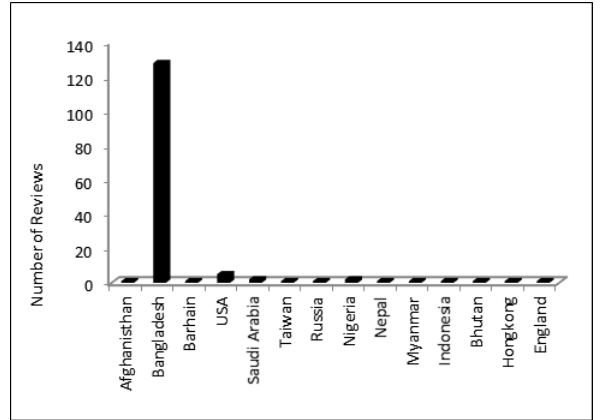
Figure 2. Nationality wise distribution of the